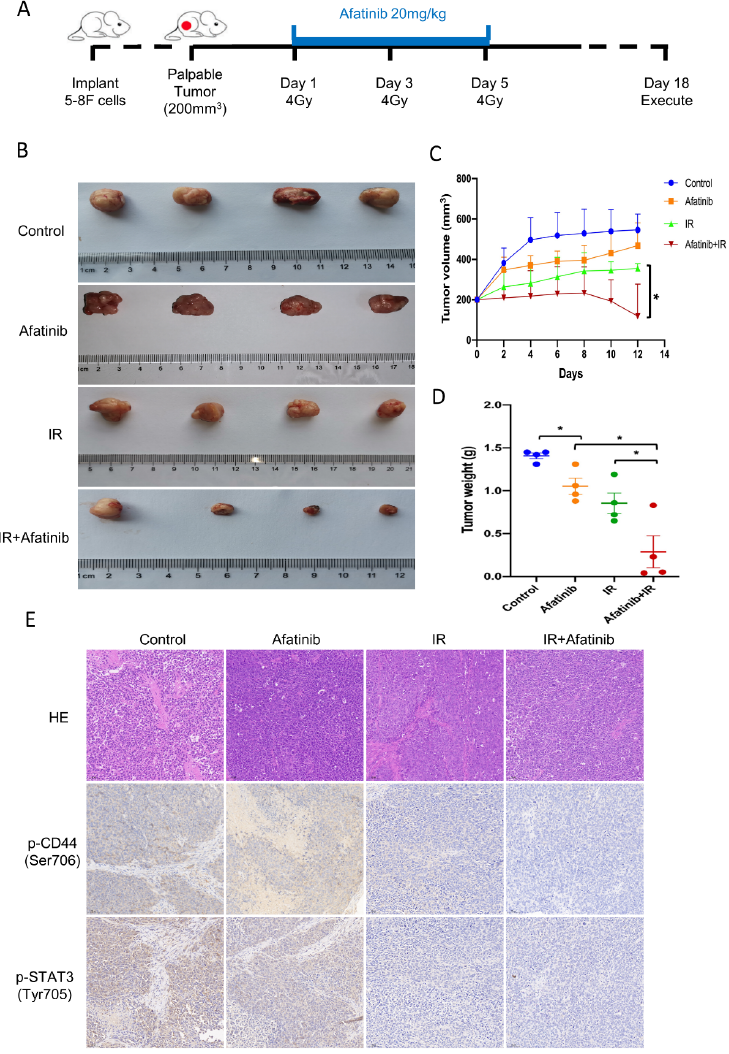
Figure 7. Afatinib enhanced sensitivity to IR in vivo . ( A ) Schematic of the xenograft mouse experi- ment. 5-8F cells were injected subcutaneously into the right flank of male nude mice. When tumor volume reached about 200 mm 3 , mice were induced with indicated treatments. After two weeks, the mice were executed, HE and IHC experiments were performed. ( B ) Representative images of dissected xenografts. ( C , D ) Tumor volume ( C ) and tumor weight curve ( D ). ( E ) Representative images of HE and IHC staining from xenografts. * denotes p <